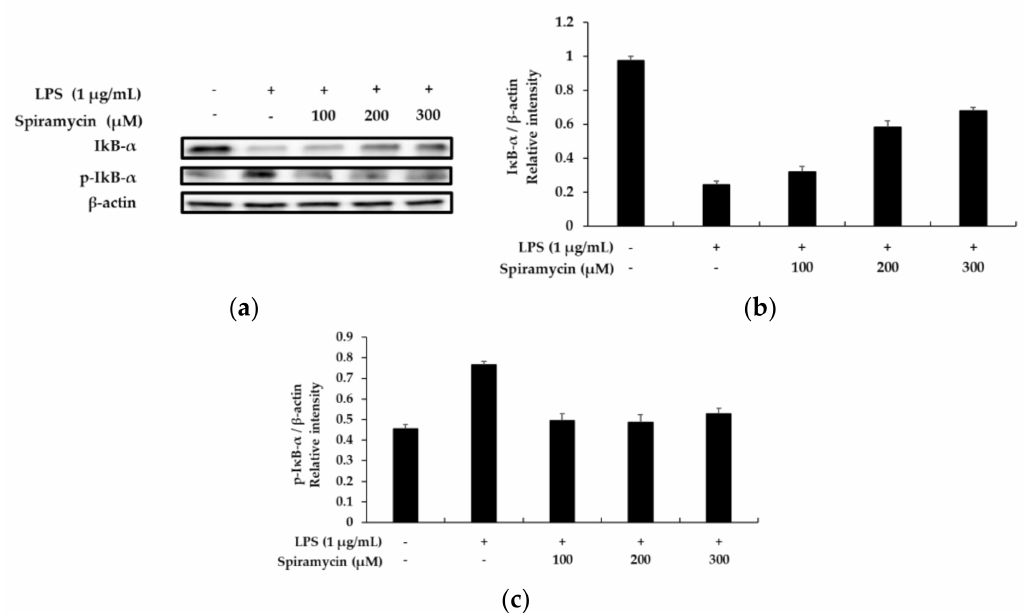
Figure 4. The effect of spiramycin on the level of nuclear factor κ B (NF- κ B; p-65; nucleus) and (p-65; cytoplasm) in LPS-induced RAW 264.7 cells. Lysates were prepared from cells pretreated with spiramycin (100, 200, and 300 µ M) for 1 h, and then treated with LPS (1 µ g/mL) for 15 min. ( a ) Western blotting results, and protein expression of ( b ) p65 (nuclear) and ( c ) p65 (cytoplasm). β -actin and Lamin B1 were used as a loading control. The results are presented as the mean ± SD from three independent measurements using the Image J.